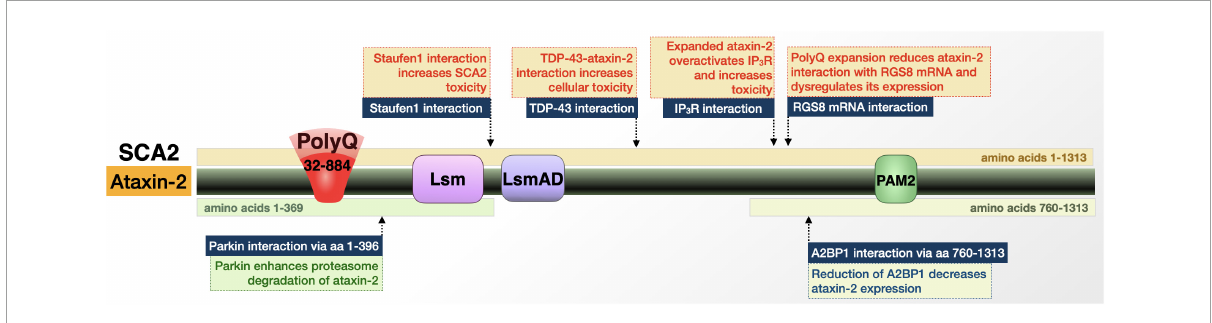
FIGURE6 Graphic representation of the SCA2 protein, its domains, interactions, and modifications. Details are in the main text.